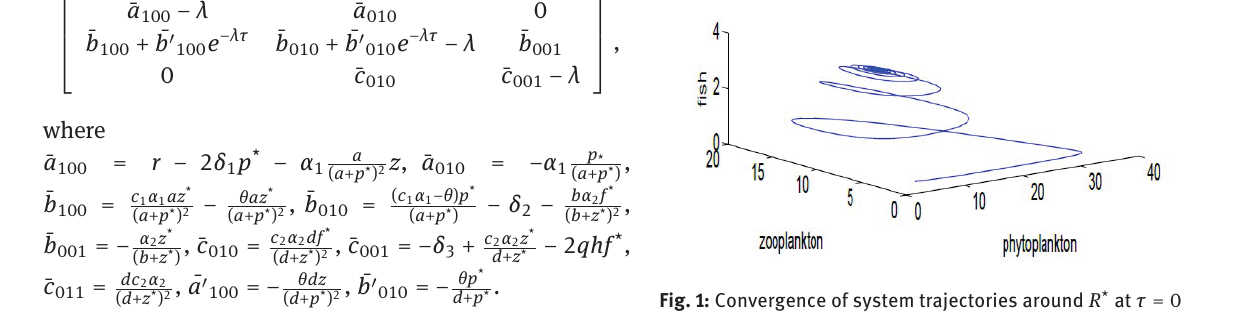
> 2 Π , ( k ≥ 1) k σ 0 for ( z ( t ), τ , T ) be- k